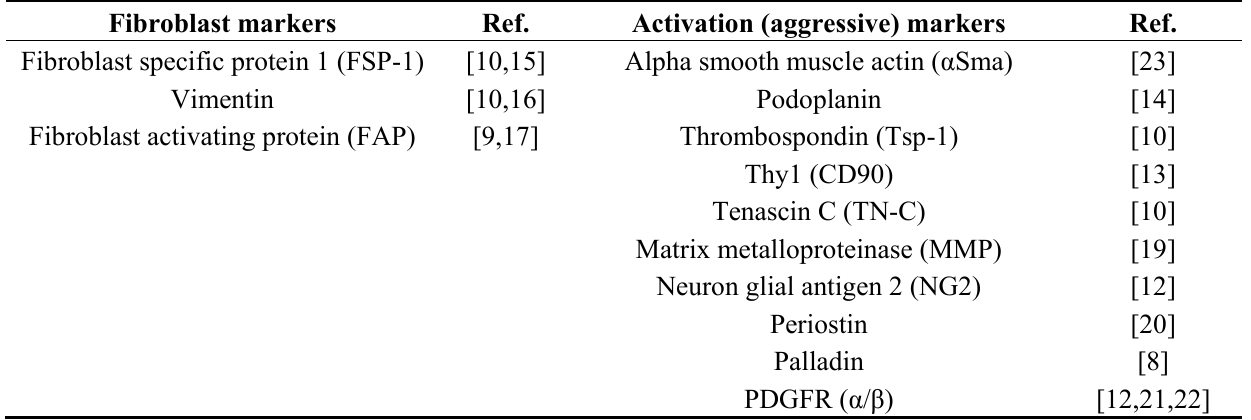
Table 1. Summary of the markers for cancer associated